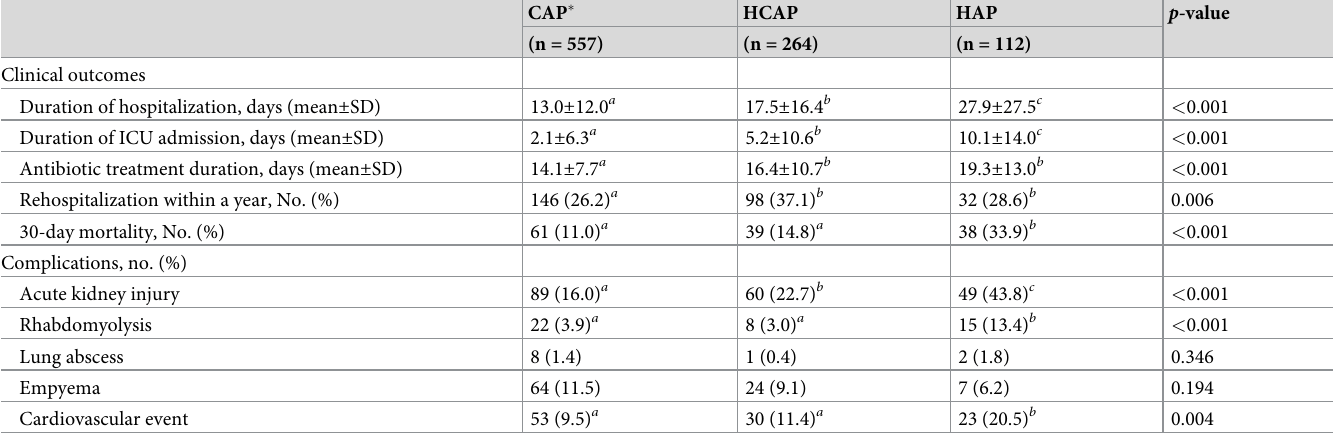
Table 5. Comparison of clinical outcomes and complications of hospitalized patients with